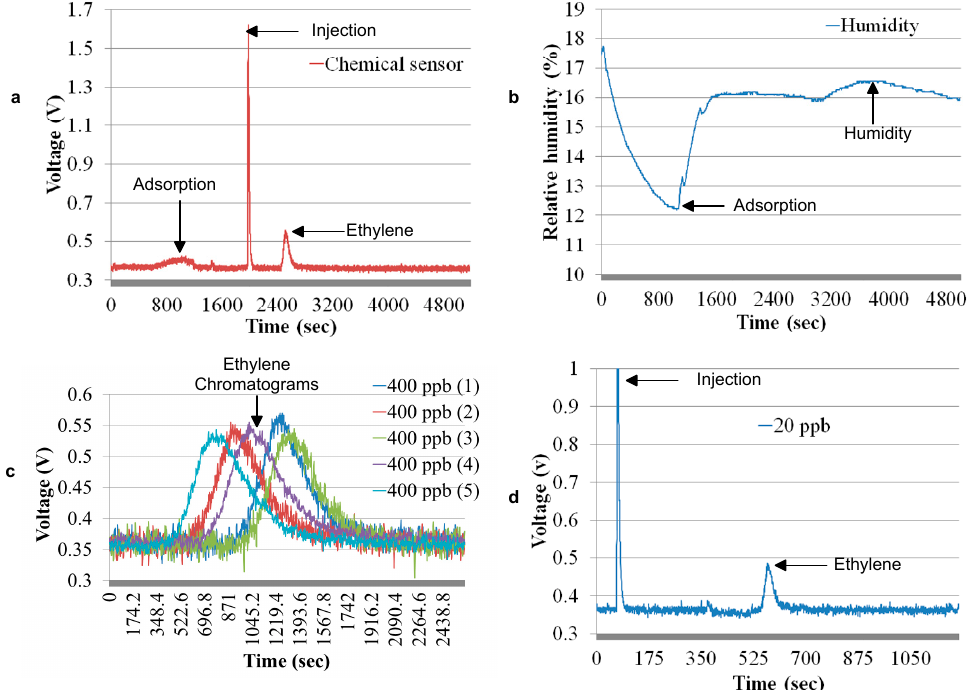
Figure 11. ( a ) 400 ppb with air as a carrier gas; ( b ) 400 ppb with air carrier gas with a humidity sensor; ( c ) sensor repeatability; ( d ) 20 ppb with air as a carrier gas.